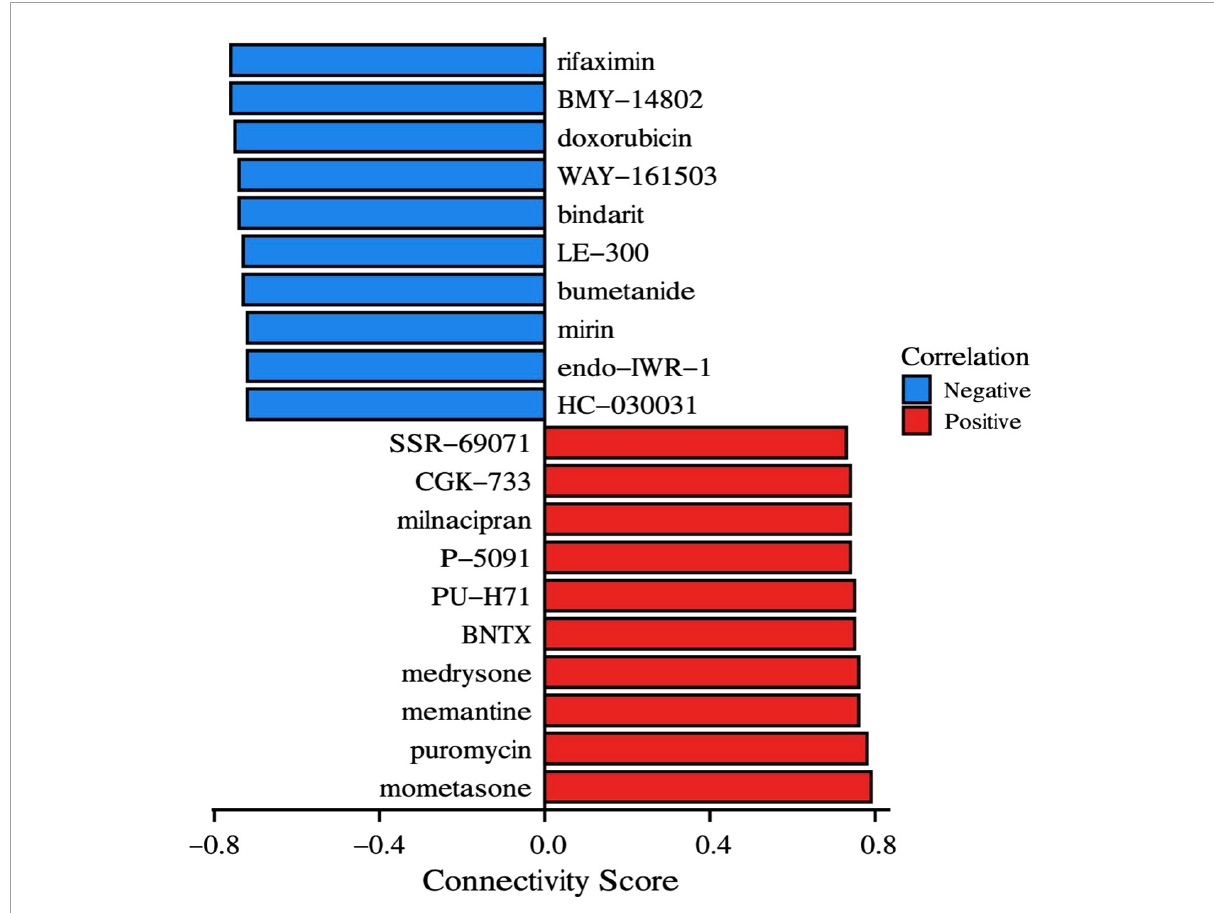
FIGURE13 Drugs prediction. CMap instances organized by compounds and cell lines depict the most significant positive and negative correlations to the impact on SCZ. The connection score, shown on the x-axis, represents the strength of the